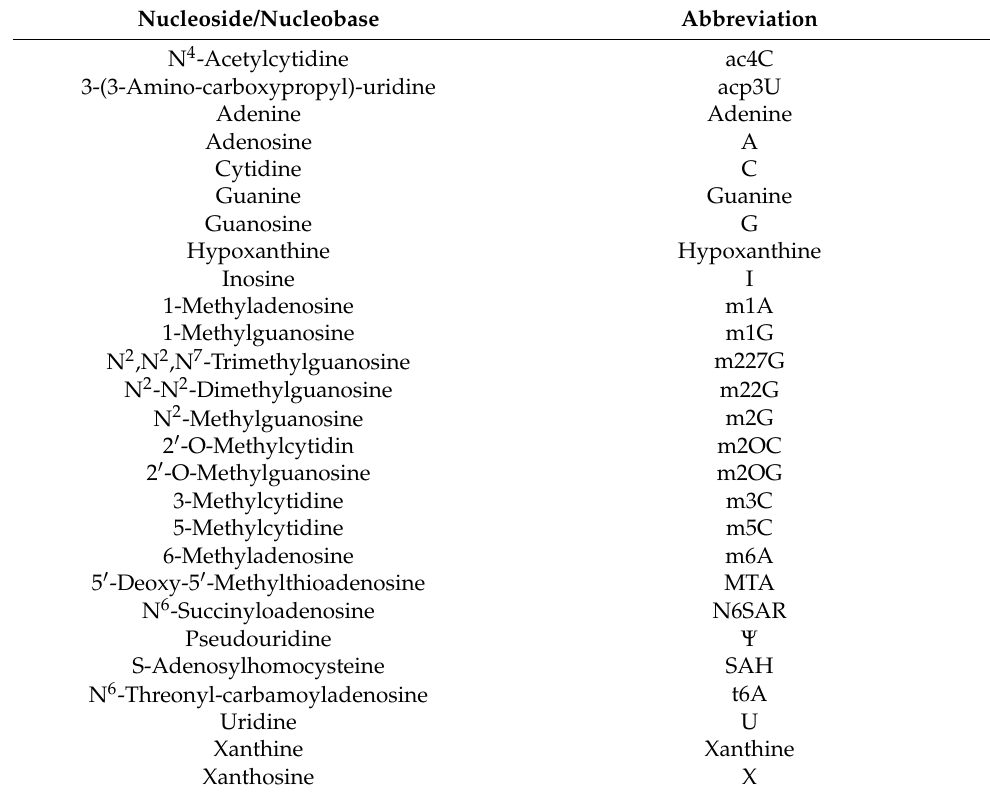
Table 1. Analyzed nucleosides/nucleobases and their